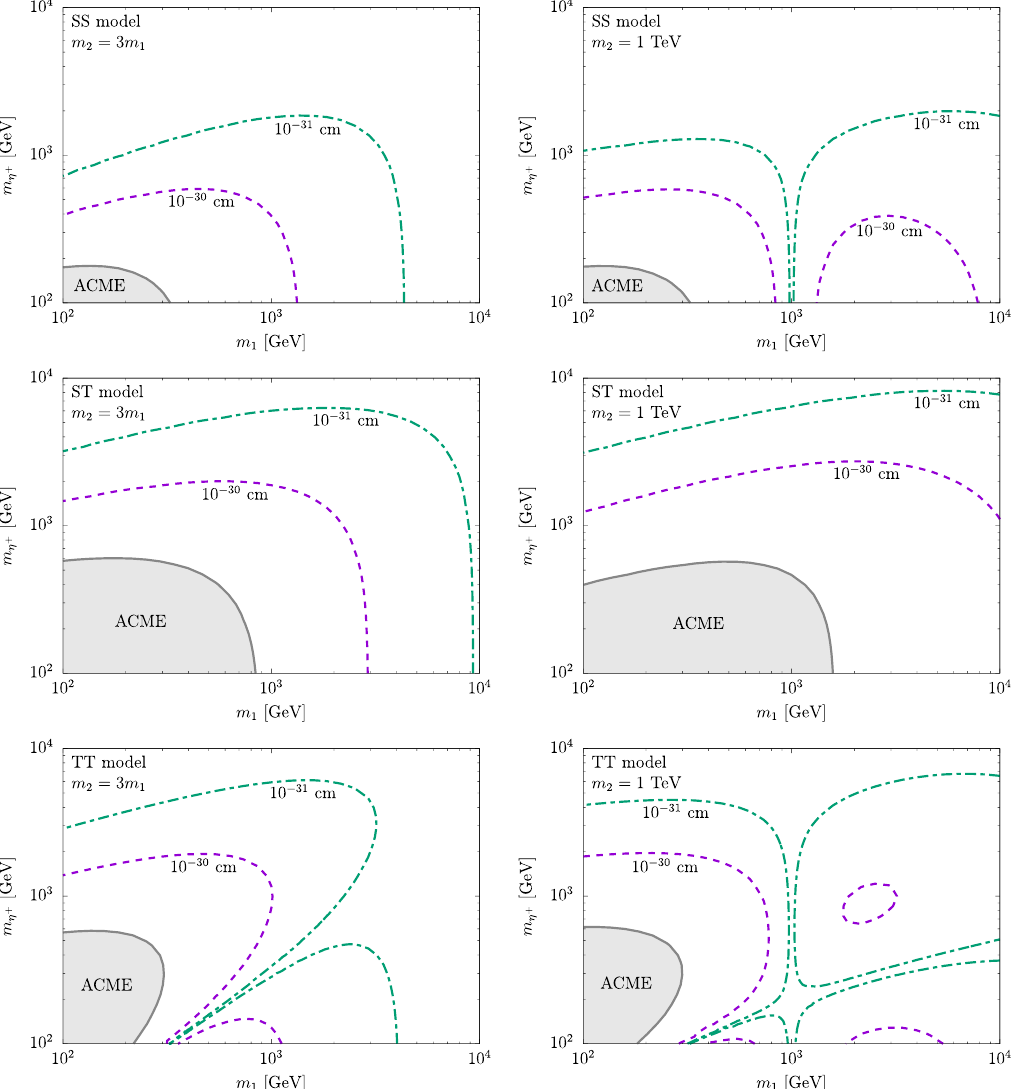
) plane where the phase η +